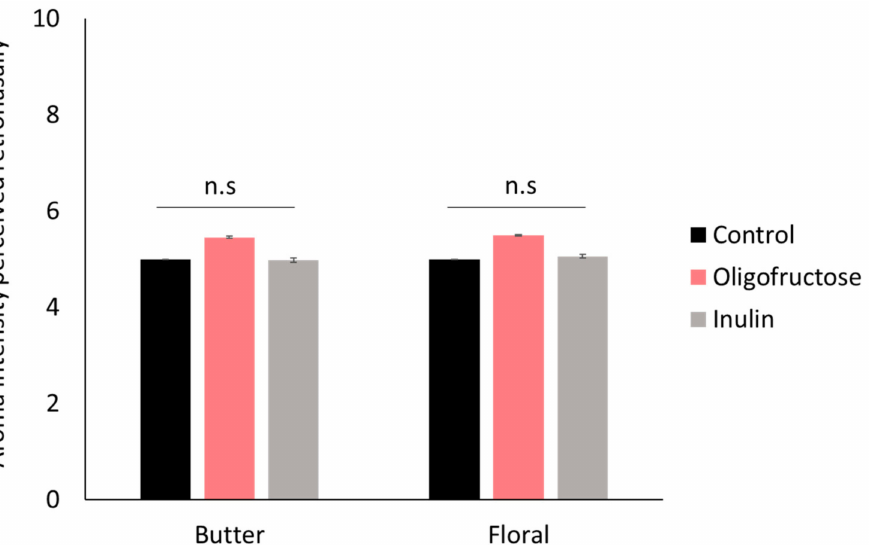
Figure 2. Retronasal perception of butter and floral notes perceived by 26 elderly individuals in solutions with prebiotic fibres added (oligofructose, inulin) in comparison to a control sample with no matrix added. Mean value ± standard error ( p >